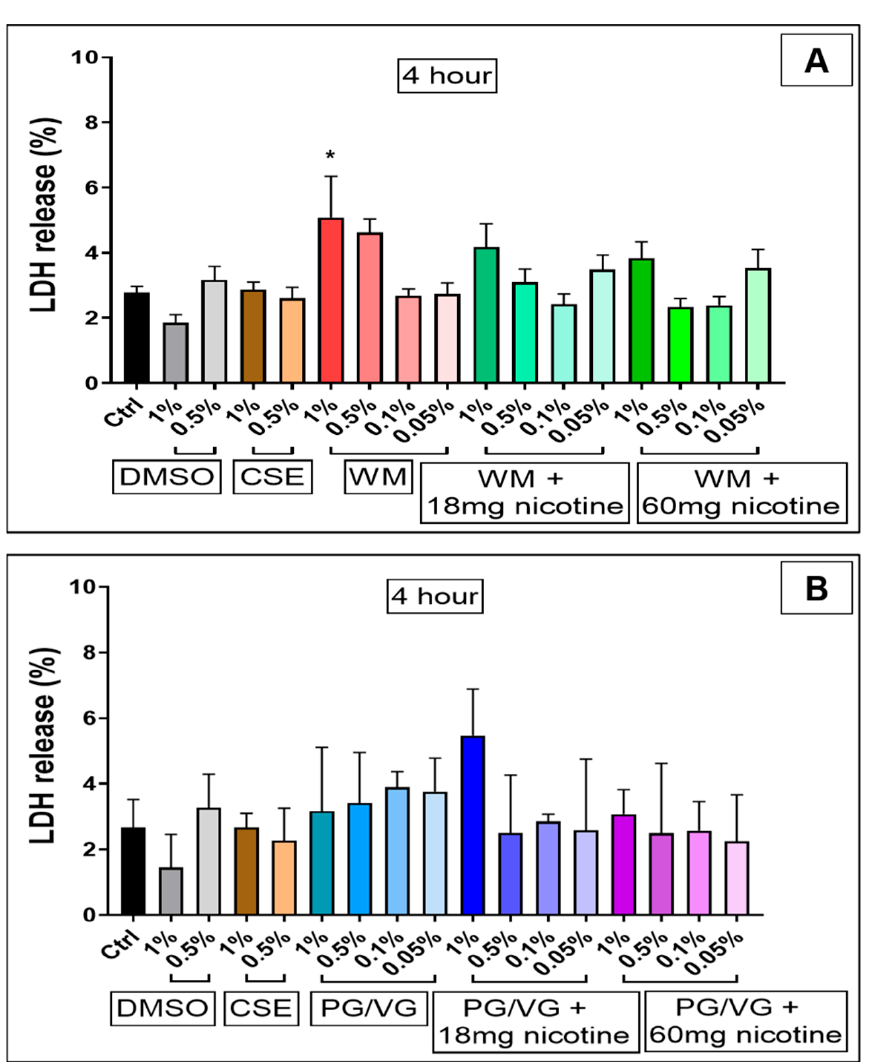
Figure 4. Membrane integrity of BEAS-2B cells following 4 h electronic cigarette aerosol and cigarette smoke exposure: Bronchial epithelial (BEAS-2B) cells were exposed to increasing concentrations (0.05%, 0.1%, 0.5% and 1%) of electronic cigarette condensate from ( A ) watermelon (WM) e-liquid) or ( B ) propylene glycol/vegetable glycerin (PG/VG) ± nicotine or cigarette smoke extract (CSE, and is presented as the percentage of maximal LDH release. Data are displayed as median with an interquartile range of n = 3–4 independent experiments. Kruskal–Wallis test with Dunn’s multiple comparison test was performed. * p <